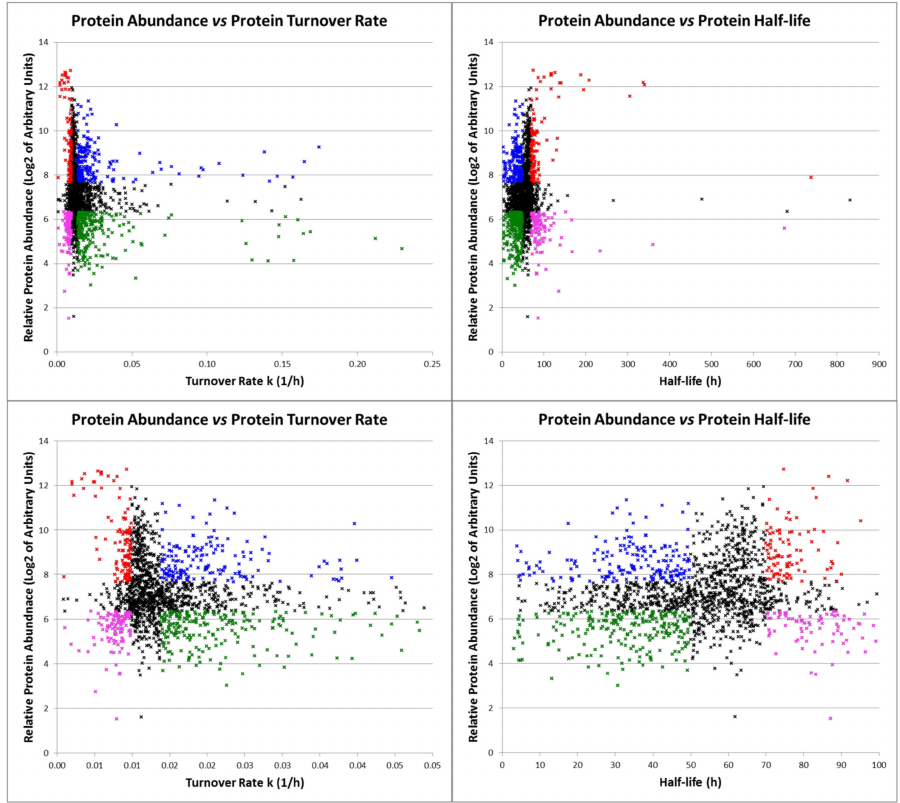
Figure 7. Distribution of turnover rates as a function of protein abundance. Left panels show the turnover rate constant k as a function of protein abundance, while right panels show the protein half-life as a function of protein abundance. Zoomed data are on display in the lower panels. Proteins characterized by a low turnover rate and high abundance are depicted in red, proteins with a high turnover rate and high abundance in blue, proteins with a high turnover rate and low abundance in green, and proteins with a low turnover rate and low abundance in